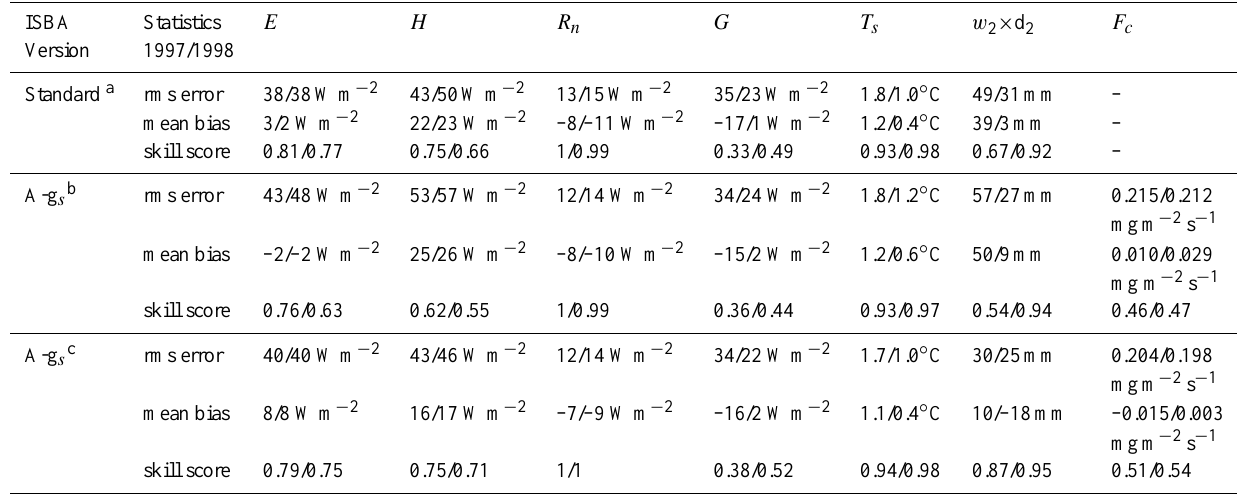
Table 4. Errors affecting the simulated Le-Bray site half-hourly outputs in 1997 and 1998 for different ISBA parameterisations in terms of rms error, mean bias (simulated minus observed), and skill score on evapotranspiration ( E) , heat flux ( H) , net radiation ( R n ) , heat storage flux ( G) , surface temperature ( T s ) , soil water storage ( w 2 × d 2 ) and net ecosystem CO 2 flux ( F c ) .